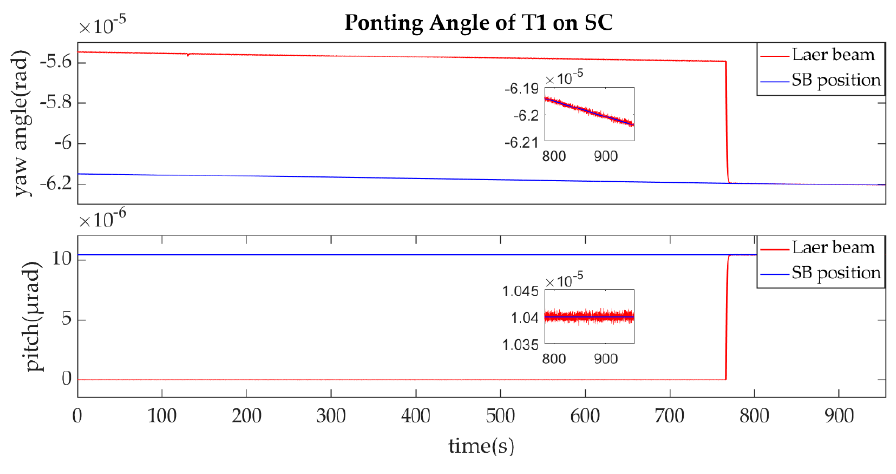
Figure 20. Ponting Angle Error of T2 on SB.